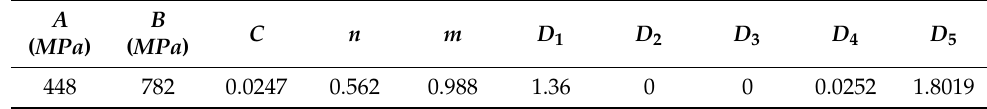
Table 1. Johnson–Cook material parameters for S355 ([32,33]).